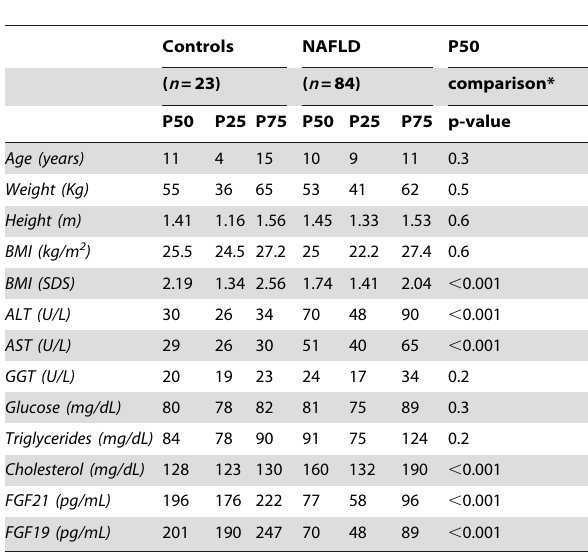
Table 1. Measurements of control and NAFLD children. Table 2. Liver histopathology of the 84 children with